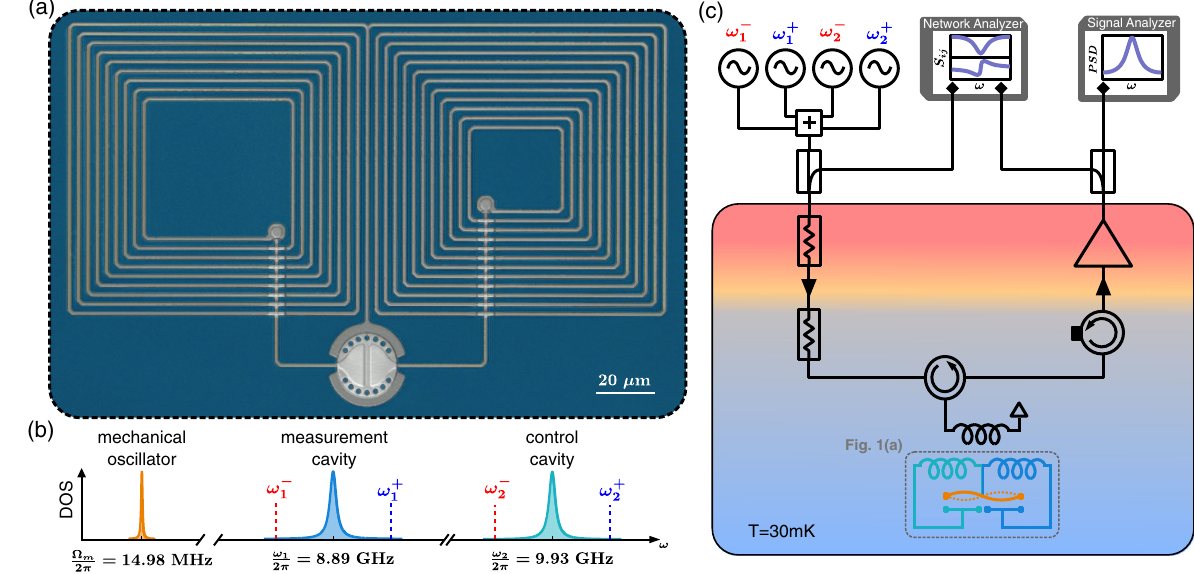
FIG. 1. Device description and experimental setup. (a) False-color optical micrograph of the aluminum device (in gray) on a sapphire substrate (blue). Centered at the bottom of the micrograph is a mechanically compliant vacuum gap capacitor. The capacitor ’ s electrode is split into two plates, each shunted by a different coil inductor, giving rise to two microwave resonances. (b) Frequency space diagram. Except for the mechanical linewidth, all the frequencies and linewidths are to scale. The microwave cavities have Lorentzian densities of states (DOS) of width κ 1 = 2 π ¼ 1 . 7 MHz and κ 2 = 2 π ¼ 2 . 1 MHz, centered at ω 1 = 2 π ¼ 8 . 89 GHz and ω 2 = 2 π ¼ 9 . 93 GHz. These resonance frequencies are tuned by the motion of the top plate of the capacitor, at the mechanical frequency Ω The red and blue dashed lines indicate the four mechanical sideband frequencies at which the cavities are driven, ω (cid:1) 1 (c) The circuit is placed on the cold stage of a cryogenic refrigerator (base temperature T ¼ 30 mK). Up to four strong microwave drives and one weak microwave probe are inductively coupled to the cavities via a single port. The reflected signals and the noise emitted by the cavities are amplified at low temperature and demodulated at room